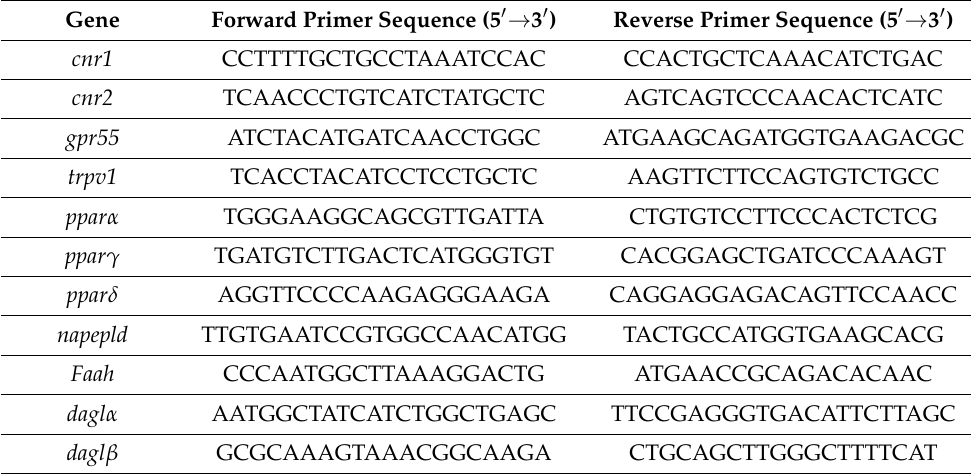
Table 5. List of primer sequences used for qRT-PCR